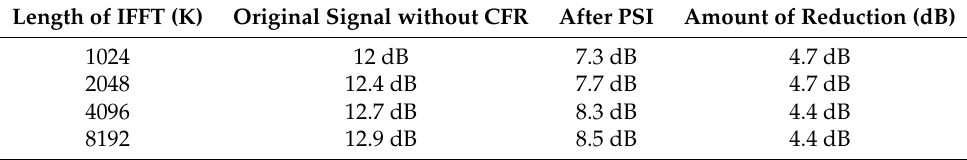
Table 3. PAPR reduction performance for different length of IFFT at 0.0001